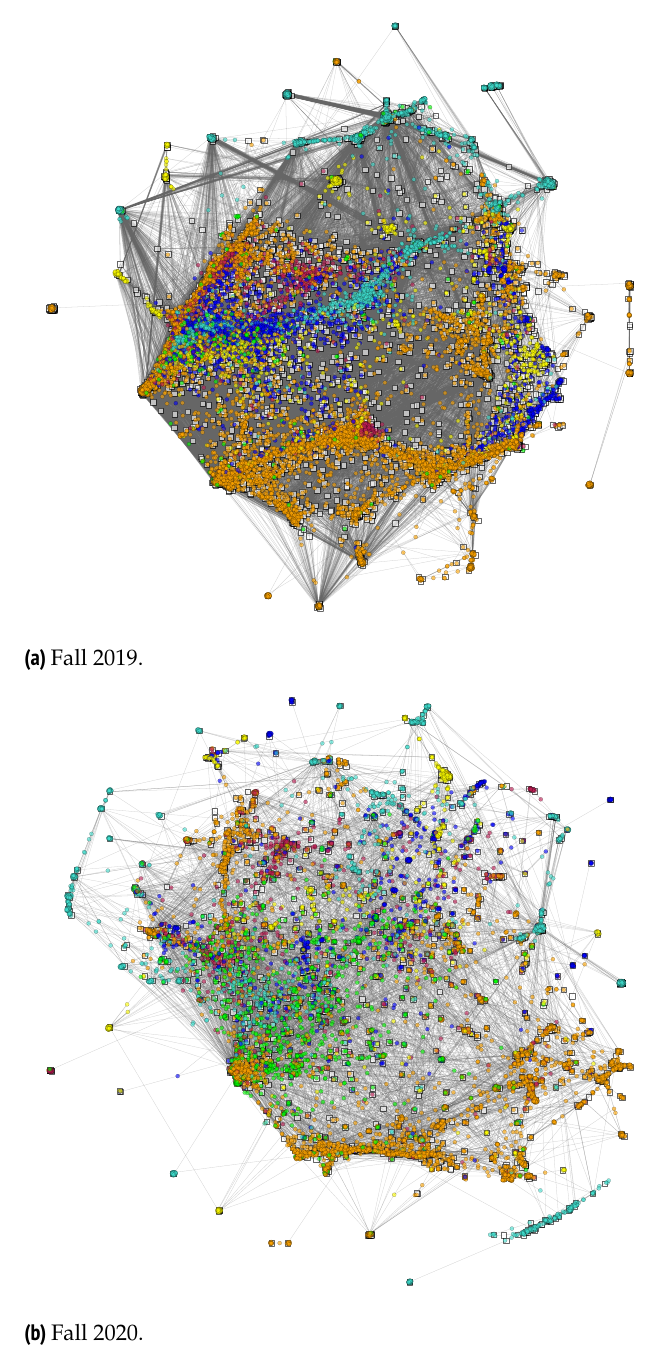
Figure 1: Note: The layout for both network plots was generated by the OpenOrd algorithm implement in the igraph package (Csárdi and Nepusz 2006). Students are represented by circles where the colors identify their fields: yellow = humanities, arts, and design; dark blue = social sciences; orange = STEM; rose red = multidisciplinary/mixed; green = undeclared; turquoise = business and law. White squares represent courses. The plots show only the largest component in each of the